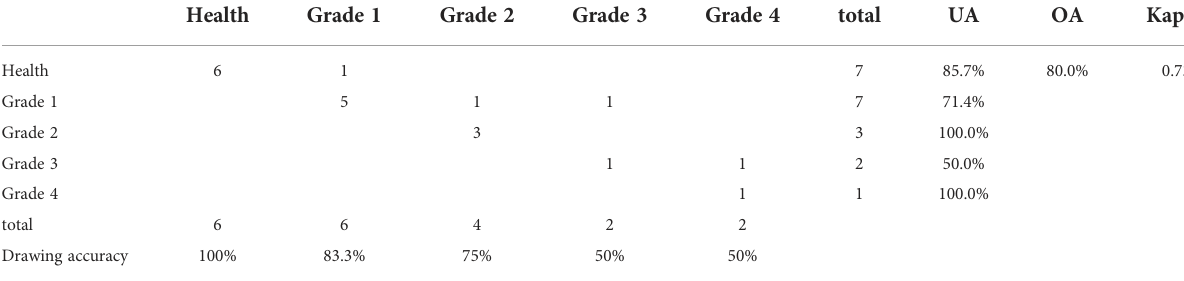
TABLE 3 RF classi fi cation accuracy of cotton aphid infestation at different